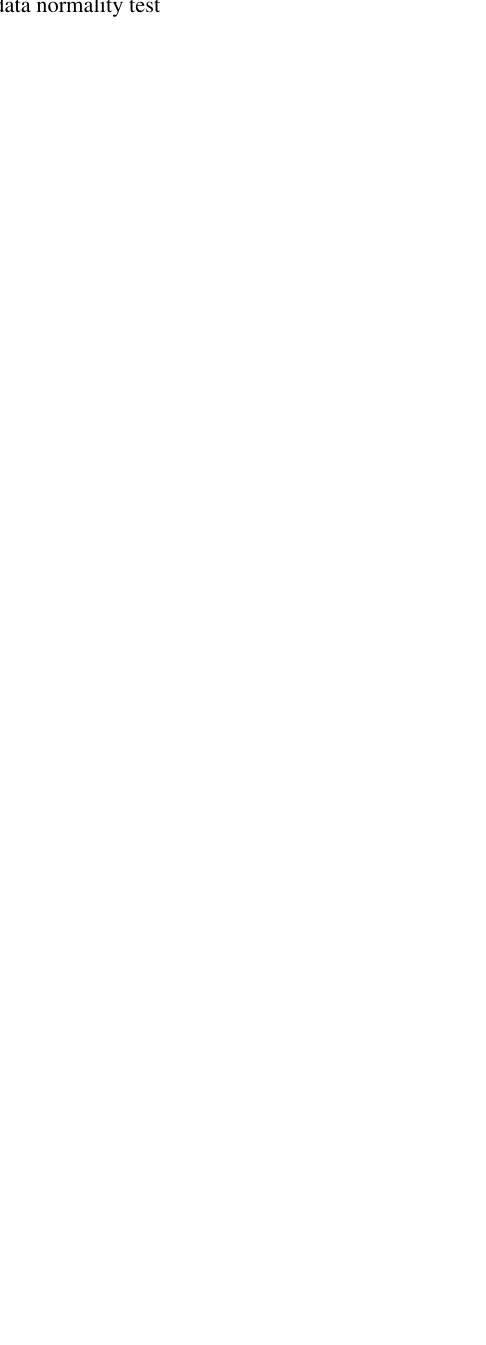
Table 2: Experimental results for data normality